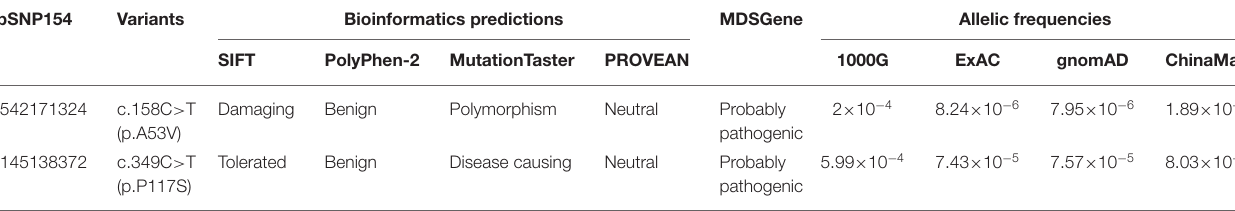
TABLE 1 | Allelic frequencies and bioinformatics predictions of the SNCA rs542171324 and rs145138372 variants. Variants Bioinformatics predictions MDSGene Allelic frequencies SIFT PolyPhen-2 MutationTaster